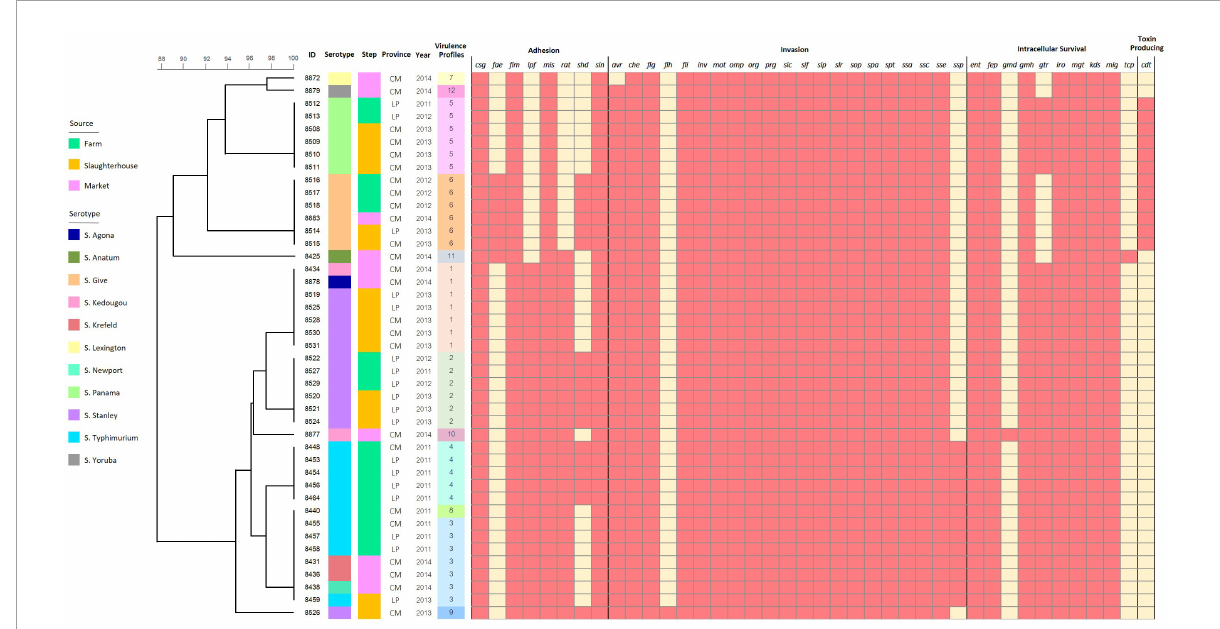
FIGURE3 Binary heatmap analysis of virulence genes harbored in the Salmonella isolates recovered from pork production chain circulating in Chiang Mai and Lamphun municipality area during the period 2011–2014.